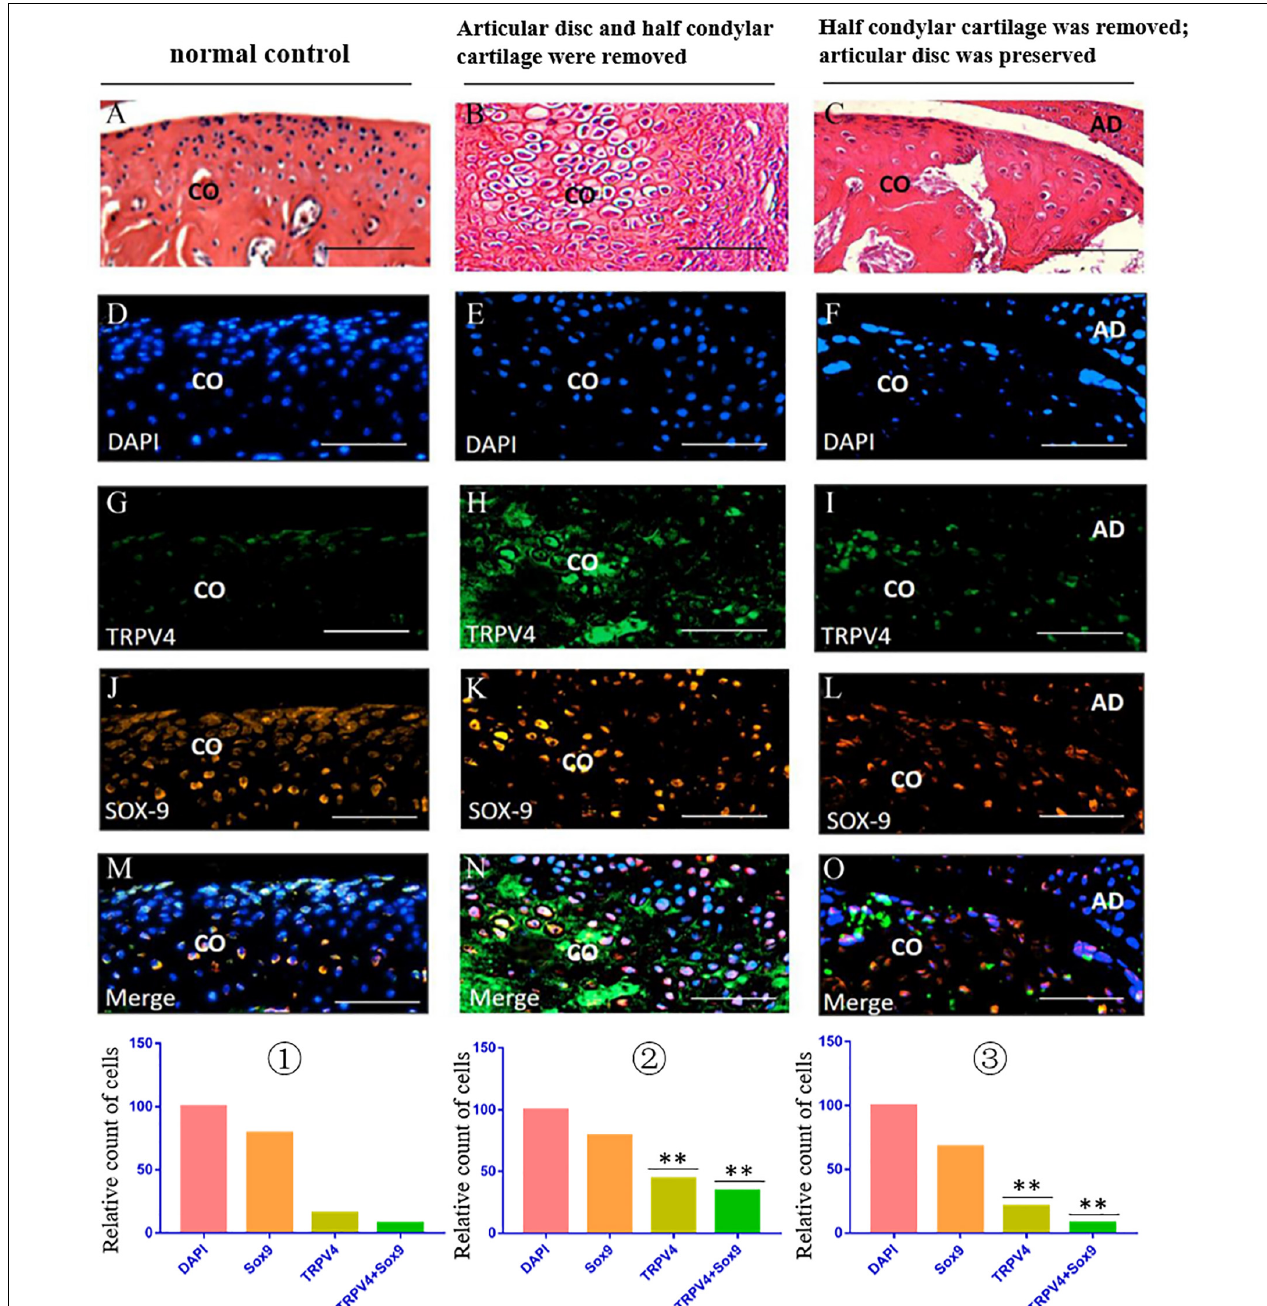
FIGURE 8 | TRPV4/Sox9 immunofluorescence double staining in the TMJ in different animal models. (A–C) H&E examination revealed the structure of TMJ in different animal models. (D–F) DAPI staining. (G–I) TRPV4 staining. (J–L) Sox9 staining. (M–O) Merge of DAPI, Sox9, and TRPV4 staining. (cid:172) The cell counts of different markers in the normal TMJ, with the count of DAPI accepted as 100 and the counts of other markers calculated and compared with the count of DAPI. (cid:173) The relative counts of TRPV4-positive cells and TRPV4/Sox9 costained cells were higher in the injured condylar cartilage in the first animal model than in the normal TMJ ( ∗∗ p < 0.01). (cid:174) The relative counts of TRPV4-positive cells and TRPV4/Sox9 costained cells were lower in the injured condyle cartilage in the third animal model than in the first animal model ( ∗∗ p < 0.01). AD, articular disc; CO, condyle. Scale bar: 50 µ